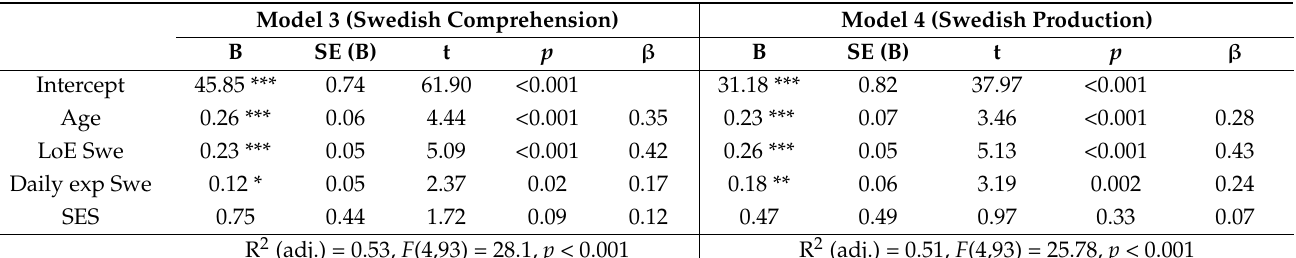
Table 5. Multivariate linear regression models for Swedish comprehension and Swedish production.